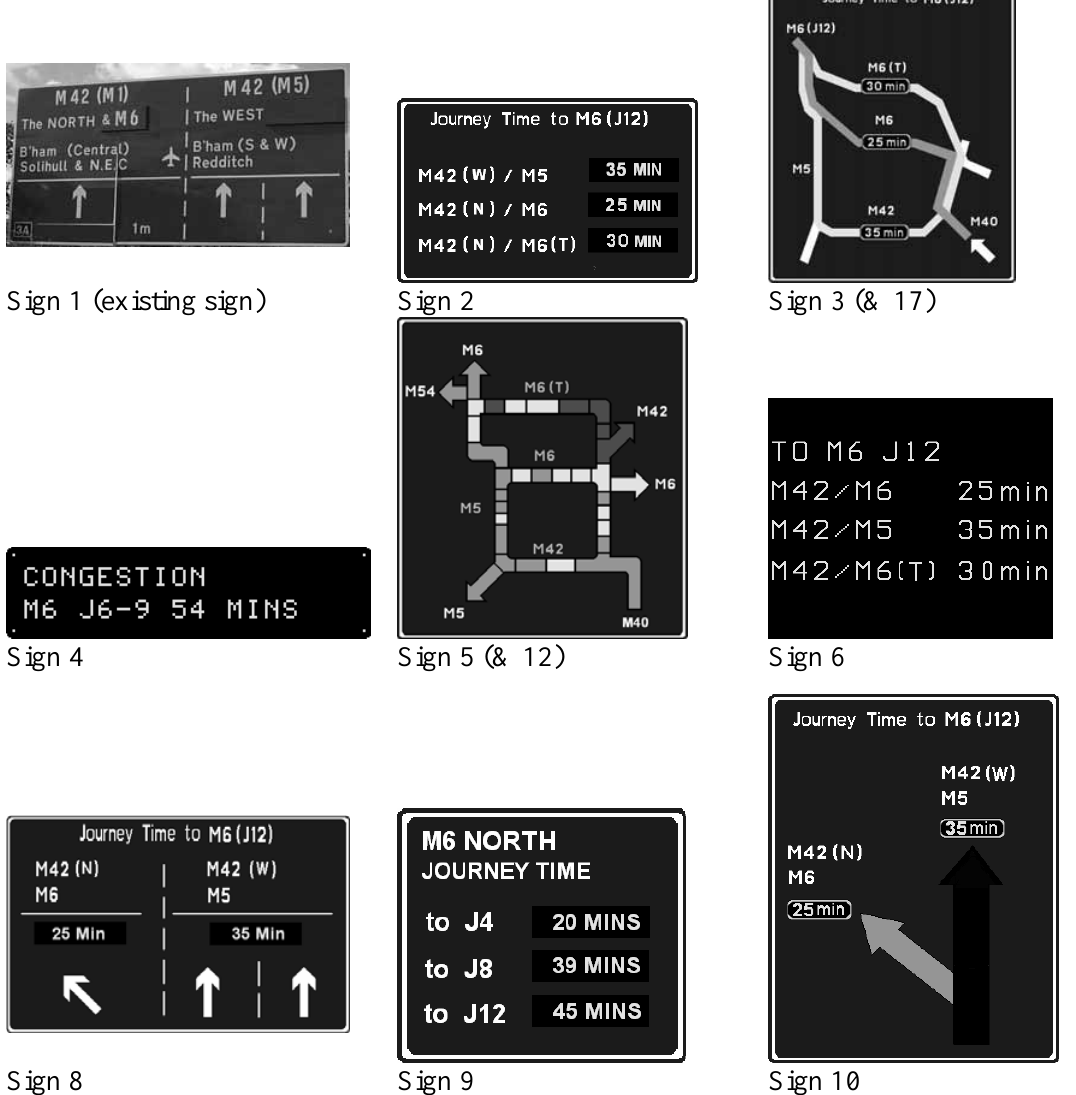
Figure 2a. Sign Designs Used in the Research Used in the Research. 17 and 12 are flashing versions of 3 and 5 respectively. Yellow and green routings are used in Sign 3and 10, while a yellow green and red scheme is used in Sign